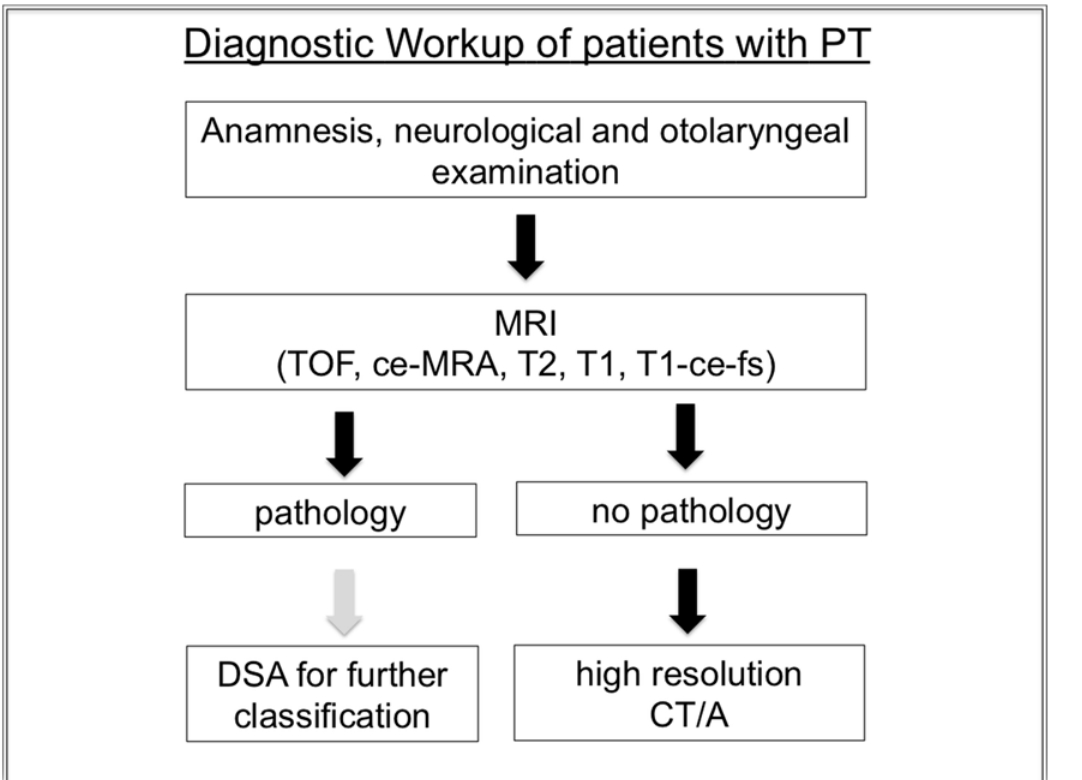
Fig 5. Diagnostic Work-Up for patients with PT. DSA is only recommended in patients with a finding of a vascular pathology in MRI.